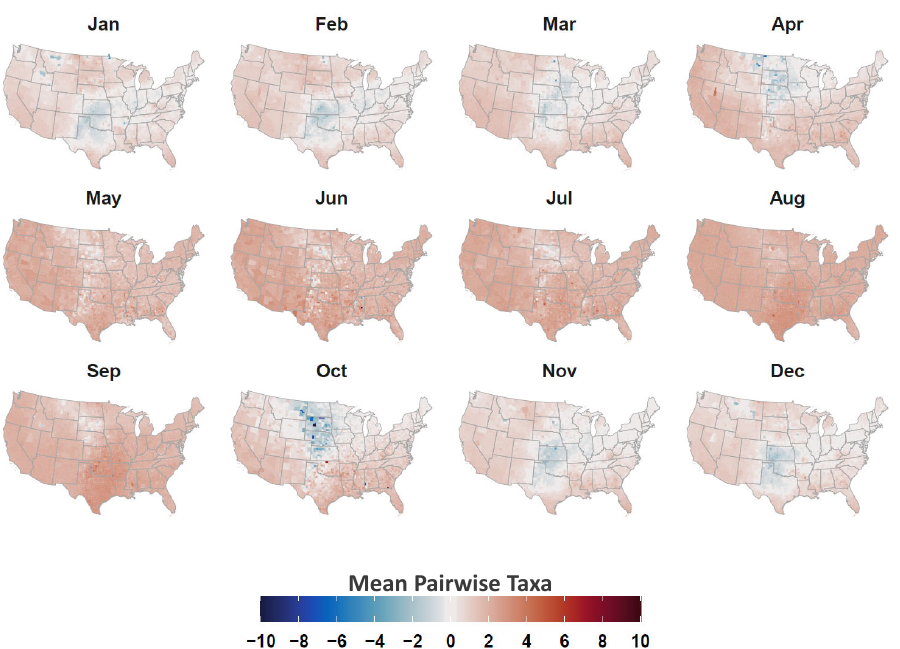
Figure A12. Dynamic avian mean pairwise taxa distance. Mean pairwise taxa covariate under assumption of a dynamic species pool (monthly varying). Covariate reflects average phylogenetic distance among co-occurring species pairs in a community. Mapped values have been centered to highlight locations subject to relative phylogenetic clustering (higher than expected relatedness, blue colors) and dispersion (lower than expected relatedness, red colors).